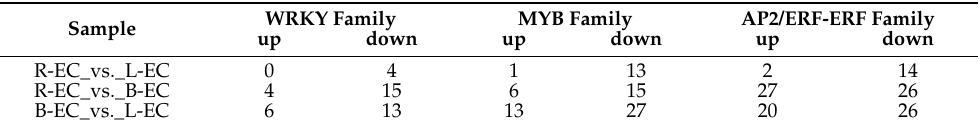
Table 3. Differences in gene expression of the WRKY, MYB, and AP2/ERF-ERF families of genes among different Korean pine samples.